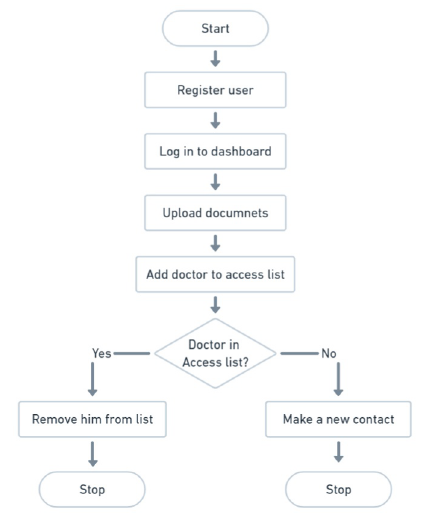
Figure 2. Flow Diagram for user